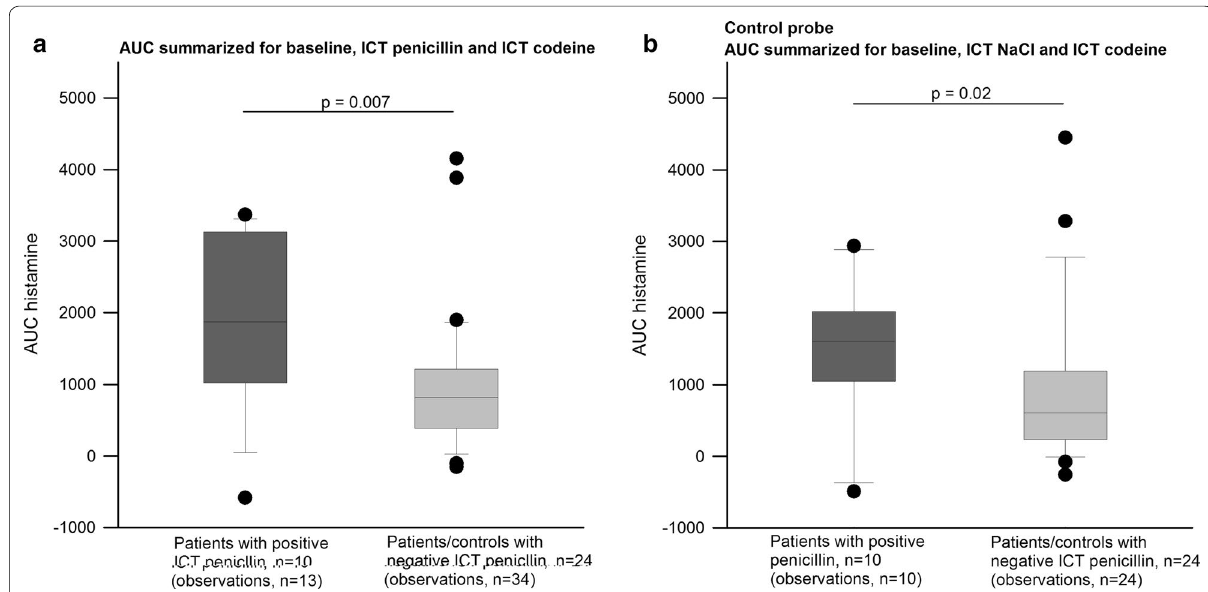
Fig. 3 Total histamine release. Box plots showing total histamine release. a Significantly more total histamine release in patients with a positive ICT to penicillin compared with patients and controls with a negative ICT. b Demonstrates that the penicillin ICT positive patients also release signifi‑ cantly more histamine in total from the control probe. Results are displayed as medians, and the boundaries of the boxes represent the 25th and 75th percentiles, the whiskers above and below the boxes are the 10th and 90th percentiles. Filled circle symbolizes an